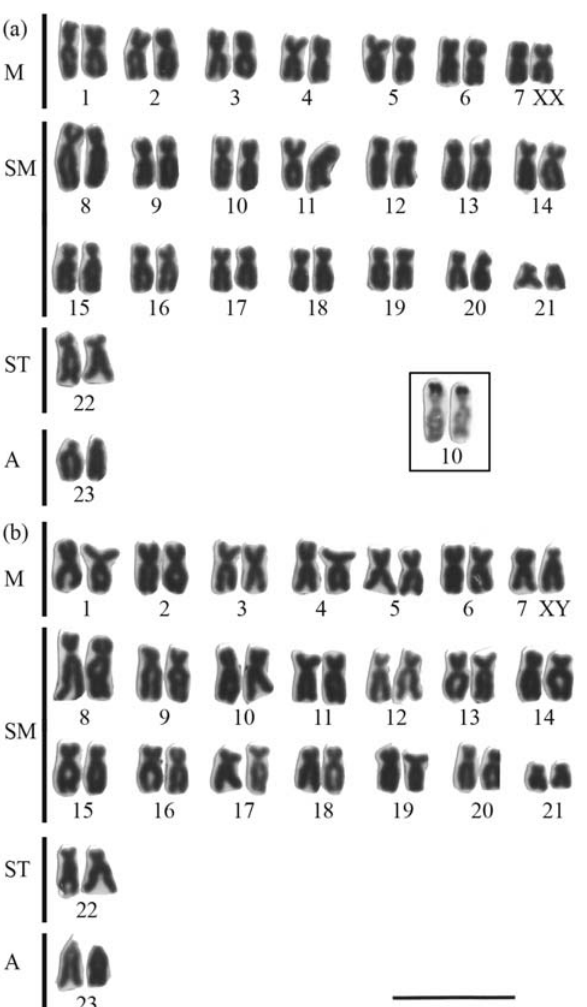
Figure 2 - C-banded karyotypes of Dormitator maculatus . (a) Female; (b) Male. Bar = 10 (cid:2)